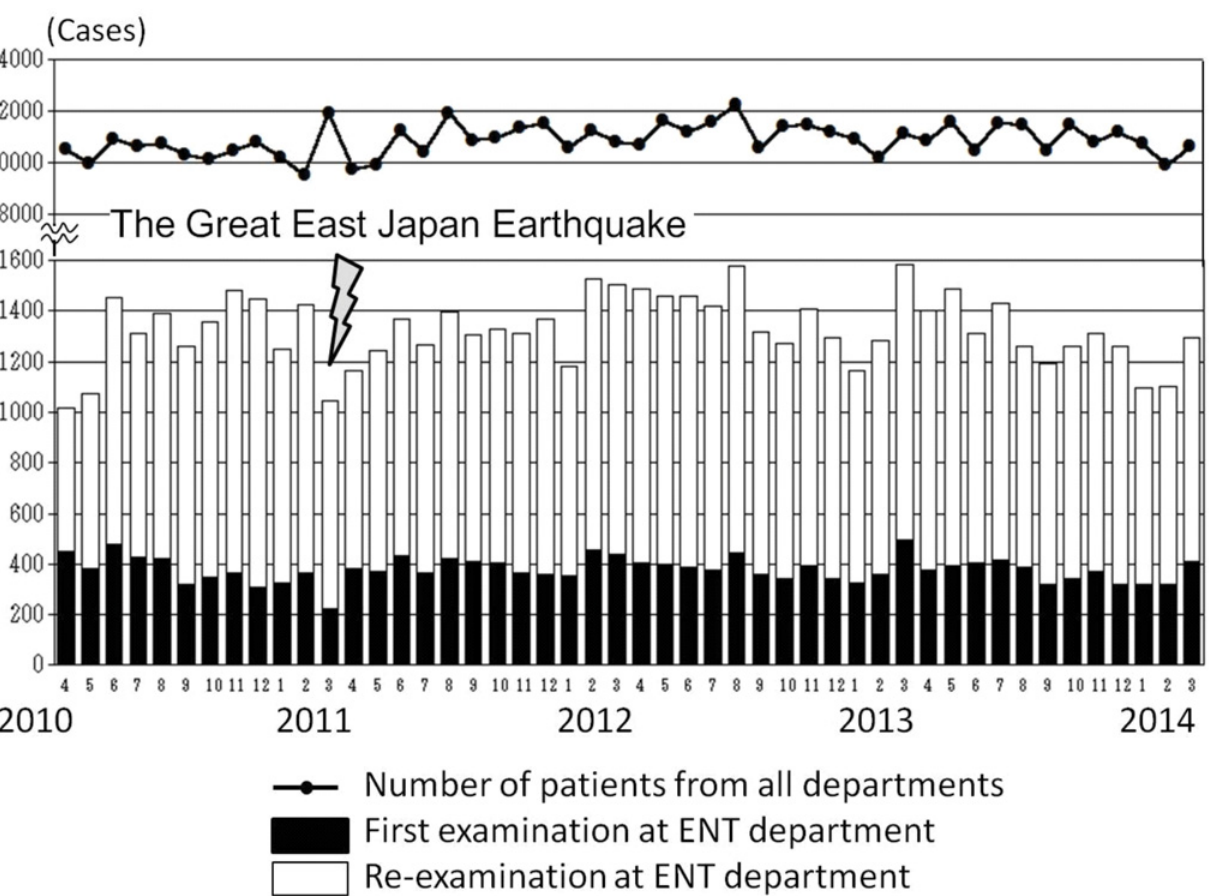
Fig 3. Number of outpatients from all the departments at Soma General Hospital, and the number of new patients and revisiting patients of the ENT department. Those patients who had not visited us for more than 6 months were regarded as new patients. After the disaster, the number of new patients increased 7.7% in the first year, 4.8% in the second year, but decreased 0.8% in the third year. Thus, the differences were small.